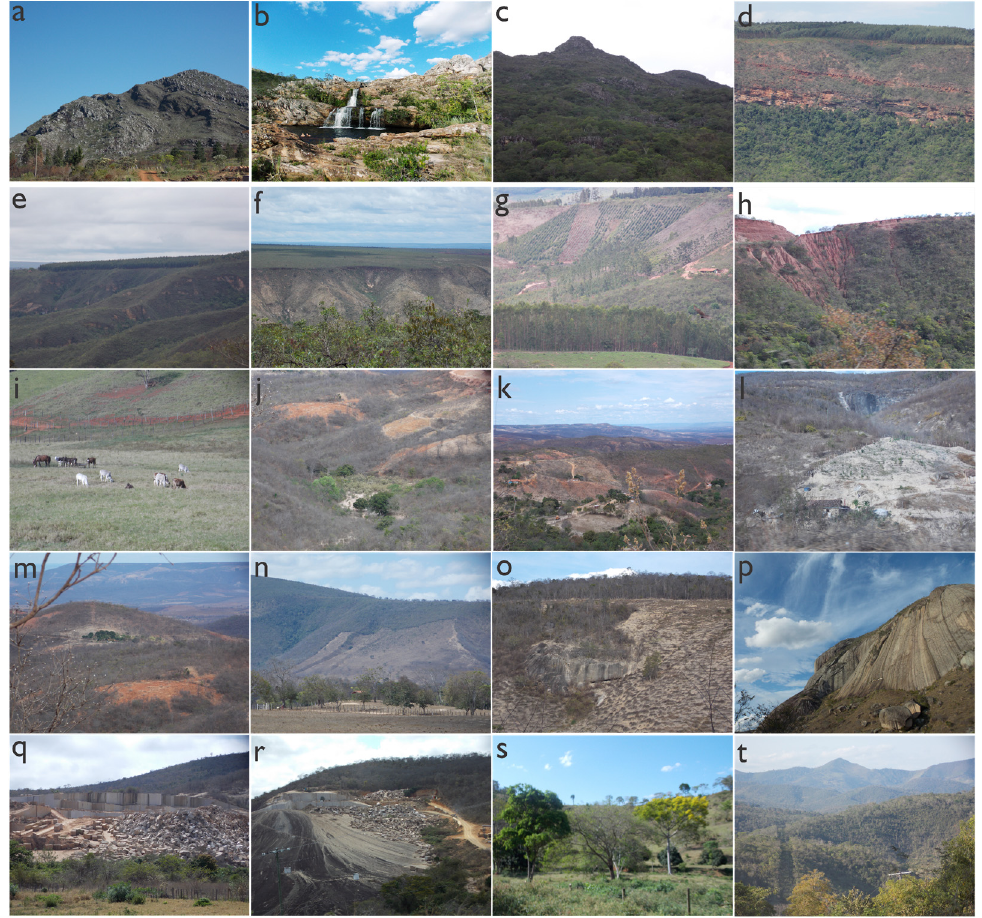
Figure 2. Landscape features of the Jequitinhonha River Hydrographic Basin, Brazil. ( a – c ) feature of the rocky outcrops and the “Campos Rupestres” of the Upper Jequitinhonha; ( d – f ) the areas of the Upper Jequitinhonha with eucalyptus forests; ( g ) sloping area of the Upper/Middle Jequitinhonha as well as the forests on the upland or plateau areas and the agricultural areas on the slopes; ( h ) sloping site in the Upper/Middle Jequitinhonha areas, which experiences problems related to erosion processes caused by the highways installed on top of the hill; ( i ) local livestock activity in the Low Jequitinhonha area; ( j – m ) the semiarid zone between the Middle/Low Jequitinhonha areas that experience intense anthropic use; ( n ) and ( o ) sloping areas with low or no vegetation cover; ( p ) rocky outcrops; ( q ) and ( r ) ornamental rock mining activity in the Low Jequitinhonha area; ( s ) and ( t ) human-influenced forested areas in the Low Jequitinhonha area.